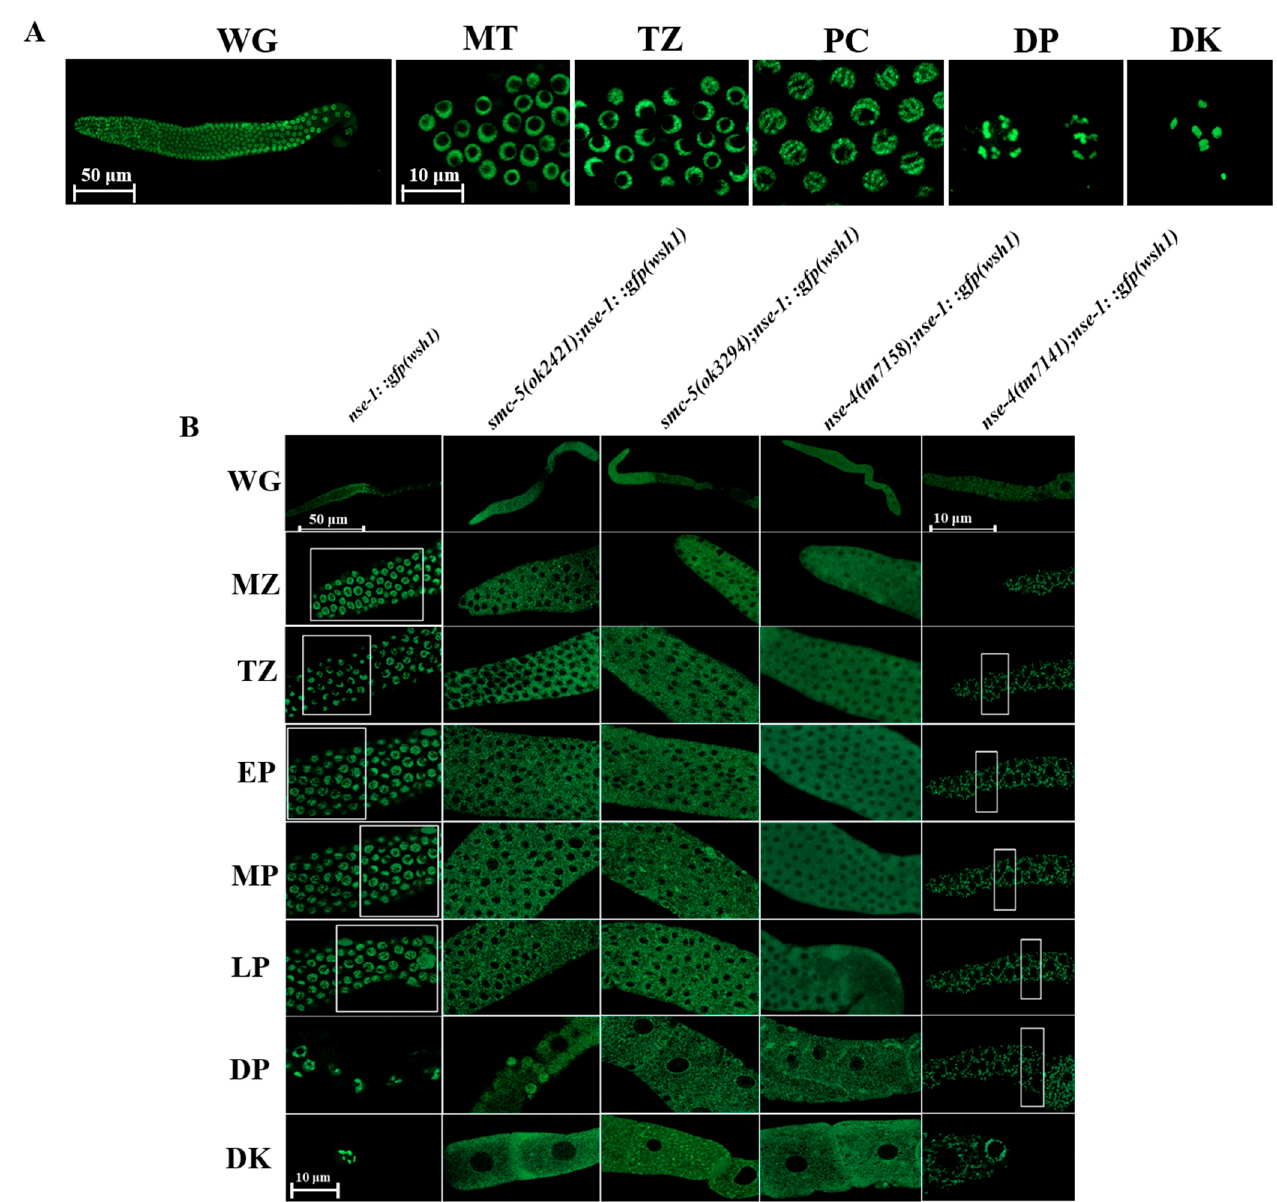
Figure 7. NSE-4 localizes on the chromosome and is necessary for NSE-1 localization. ( A ) NSE-4 localizes to the chromosome in all zones of the germline. ( B ) NSE-4 Kleisin is indispensable for the localization of NSE-1 on the chromosome. In nse-4 , smc-5 , or smc-6 mutant background, NSE-1 delocalizes from the chromosome and is translocated to the cytoplasm in all zones of the germline. All images for whole germline (WG) were captured using Zeiss LSM800 confocal microscope with 10× objective and scale bar of 50 μ m, except for the tm7141;wsh1 with a remarkably small germline in which 40× objective with oil immersion was used at a scale bar of 10 μ m. All other images of the different zones were captured using 63× objective with oil immersion and a scale bar of 10 μ m (MZ—